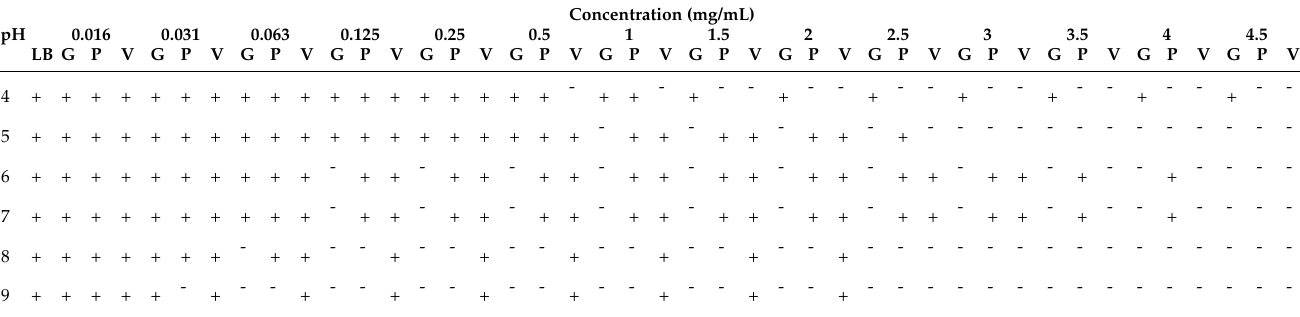
Table 1. Antimicrobial potential of phenolic acids in LB with adjusted